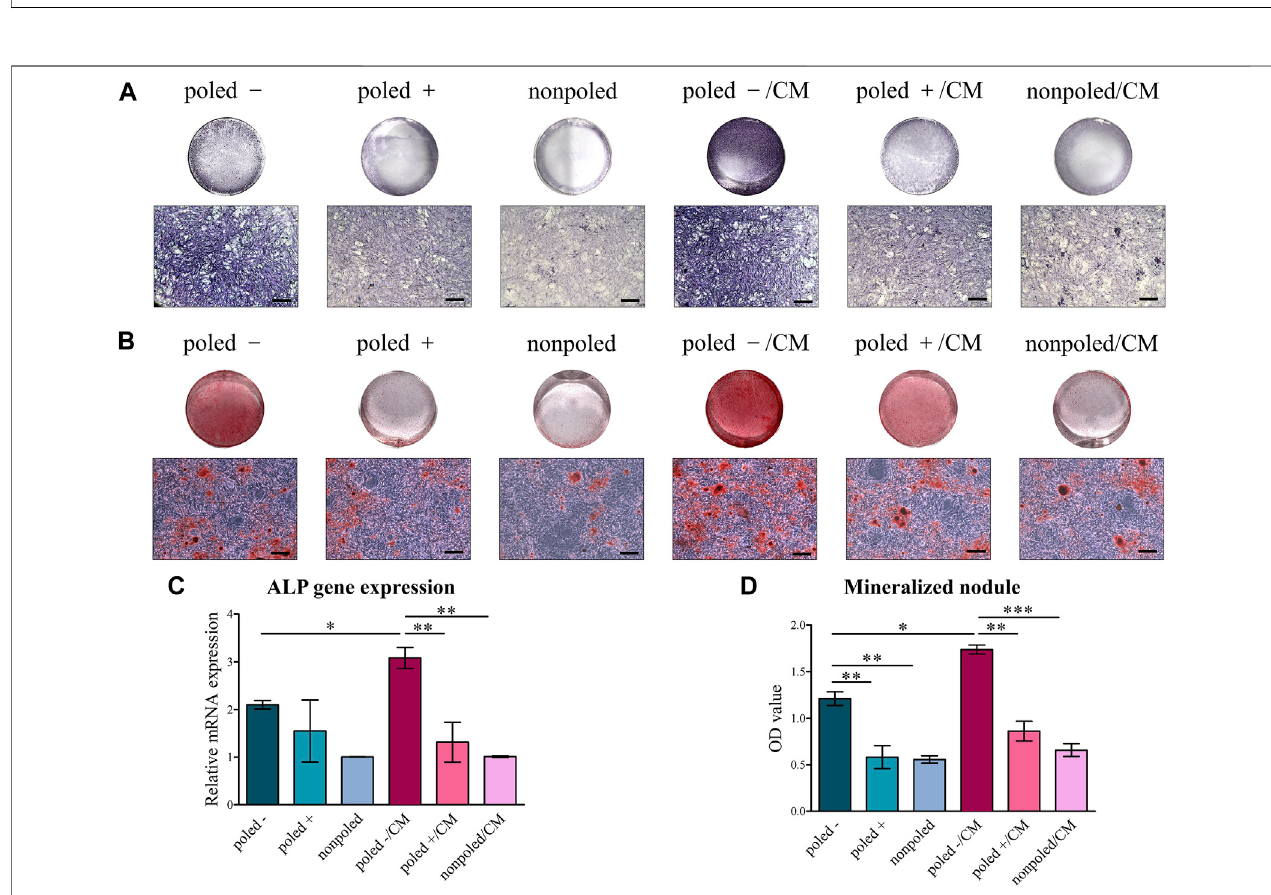
FIGURE 8 | Osteogenic differentiation of rBMSCs cultured on P (VDF-TrFE) membranes with/without CM. (A) Alkaline phosphatase staining of rBMSCs after 7 days of induction (top: macroscopic images, bottom: microscopic images, scare bar: 100 μ m). (B) Alizarin red staining of rBMSCs after 14 of induction (top: macroscopic images, bottom: microscopic images, scale bar: 100 μ m). (C) Expression of the osteogenic gene ALP ( “ nonpoled ” group as control). (D) Quantitative analysis of the mineralized nodules by alizarin red staining. * p < 0.05; ** p < 0.01; *** p < 0.001.